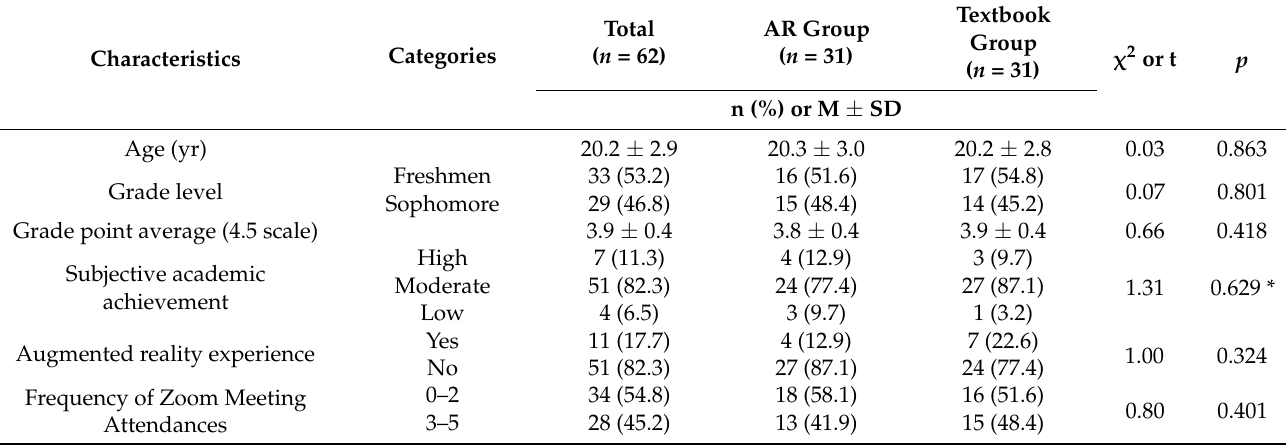
Table 1. Homogeneity for Demographic Characteristics between Two Groups ( n = 62).